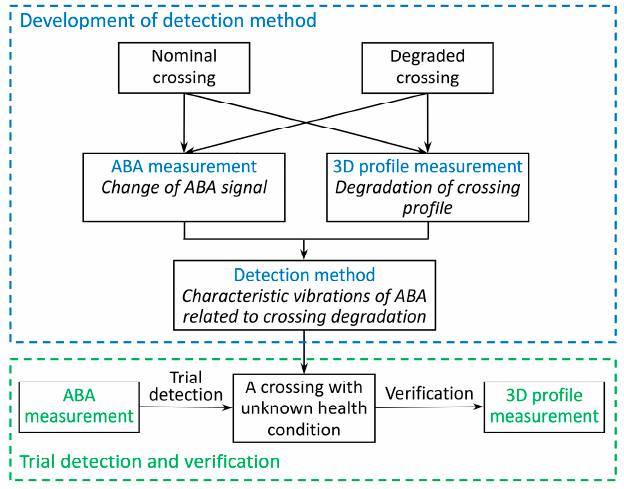
Figure 3. Structure of the methodology.